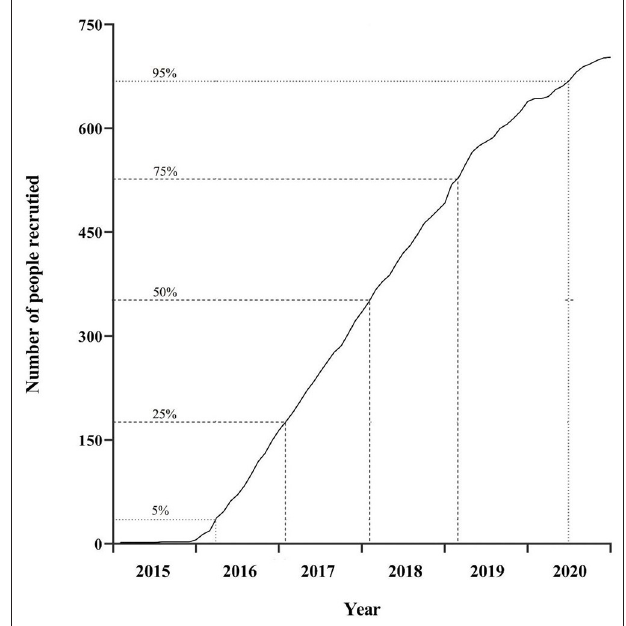
FIGURE 2 | Cumulative recruitment into the